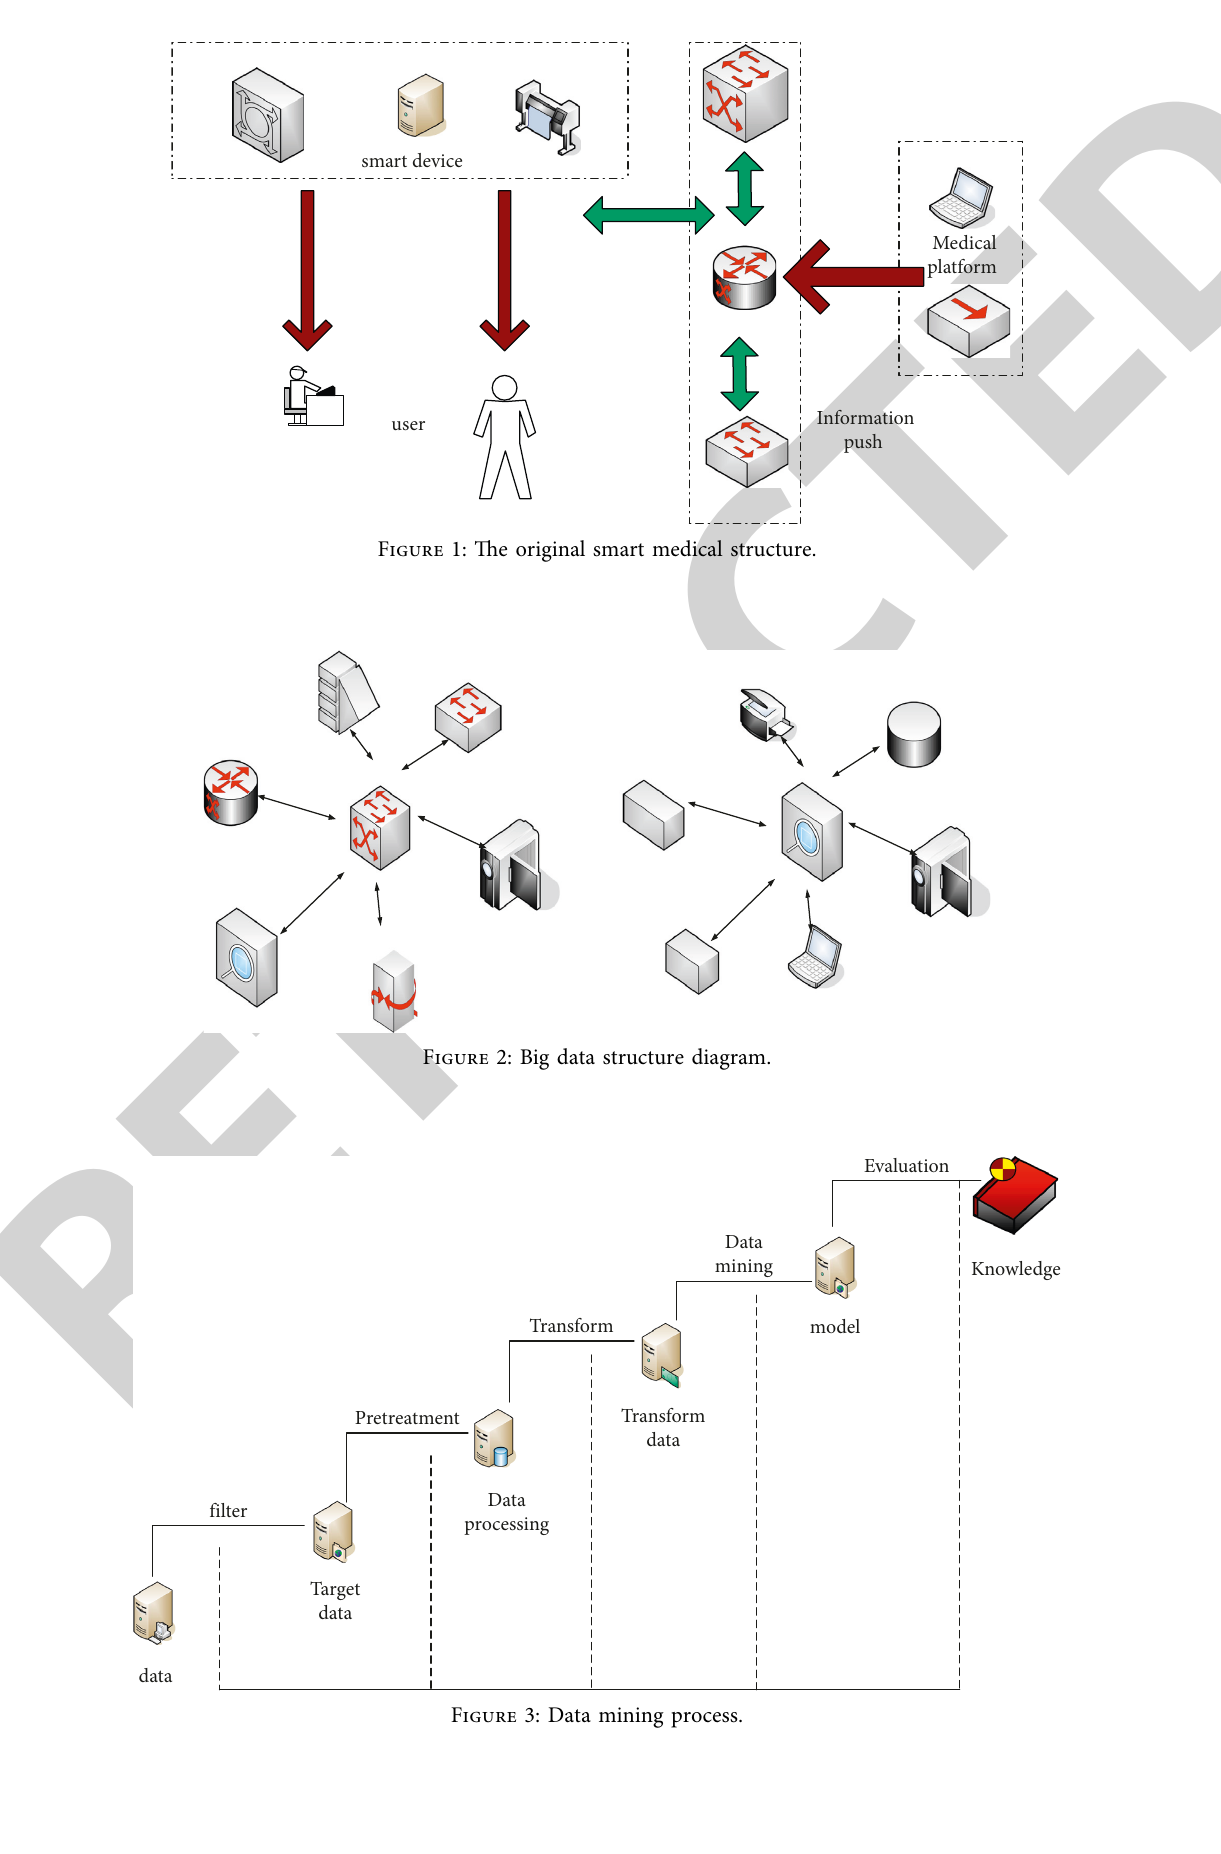
Figure 3: Data mining process.